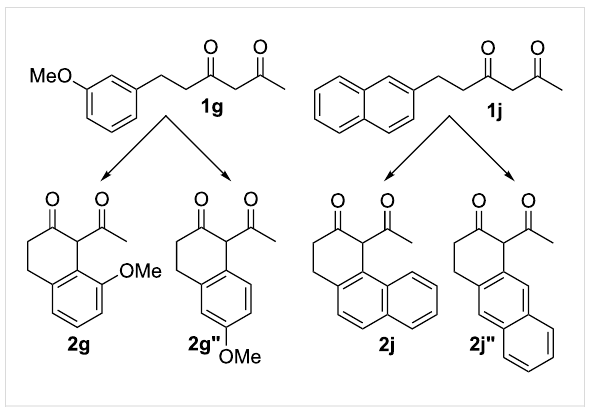
Figure 2: Possible products from the ortho cyclization of 1g and 1j